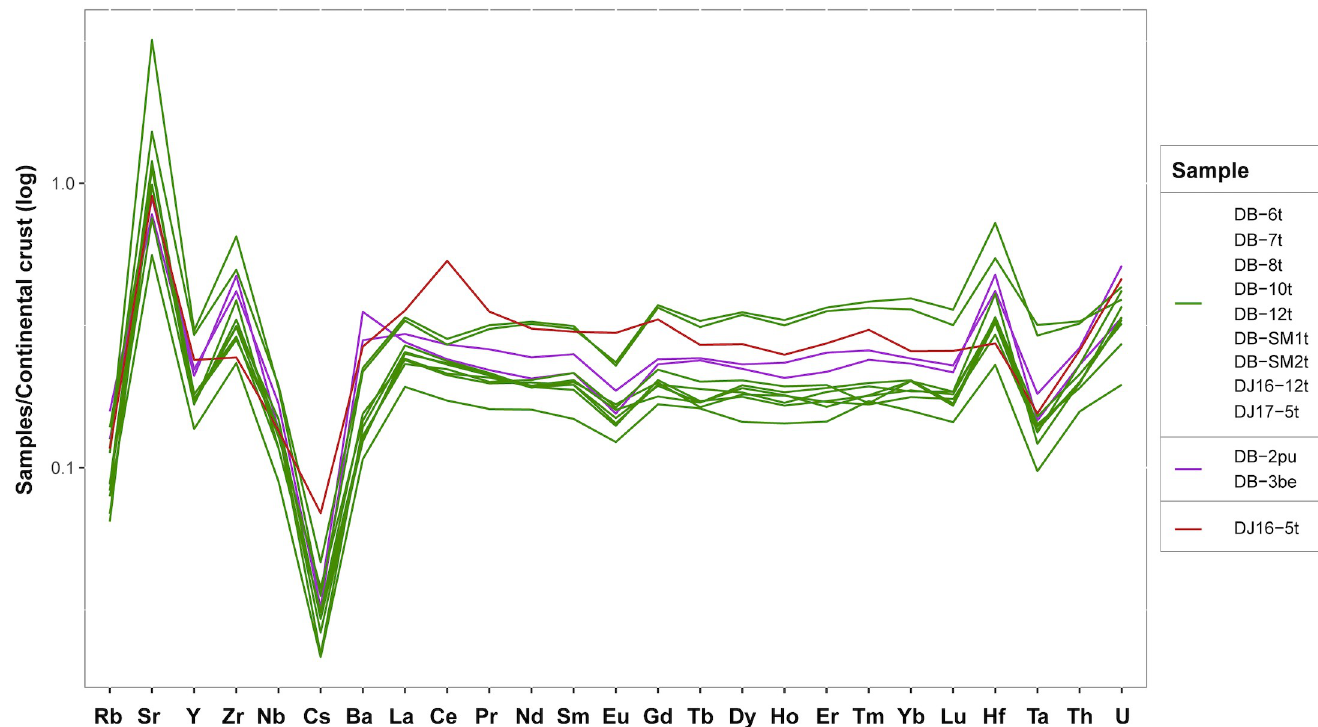
Fig 6. Subdivision of the low lime and magnesia samples based on trace element content.